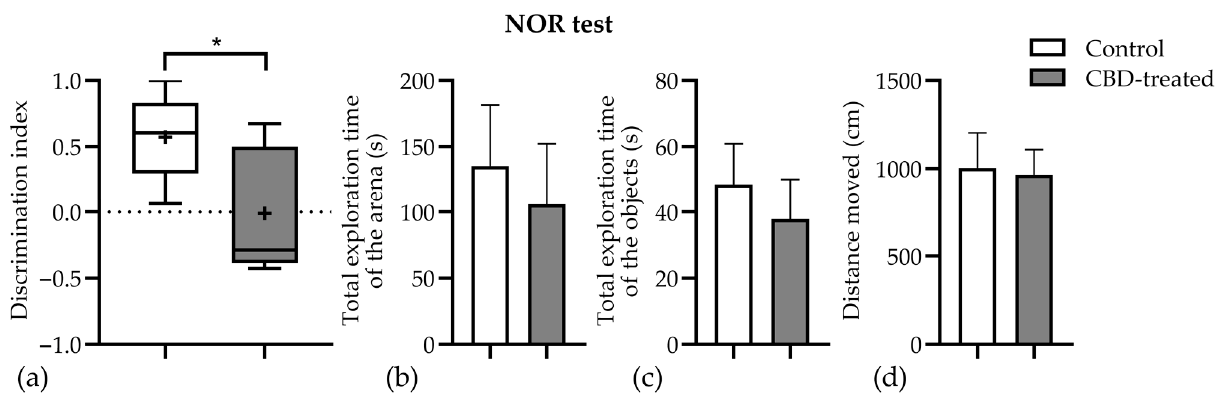
Figure 6. The effects of chronic CBD (60 mg/kg body weight) treatment on cognitive performance of rats subjected to a PTZ-kindling protocol. ( a ) Discrimination index (DI), which shows the discrimination between the novel and familiar objects, i.e., the difference in exploration time for a familiar object, but then dividing this value by the total amount of exploration of the novel and familiar objects [DI = (TN − TF)/(TN + TF)] showed a significant decrease in the CBD-treated group. + sign shows the arithmetic mean, whereas the line represents the median; ( b ) the total exploration time of the arena (mean ± SEM) did not show statistically significant difference between groups; ( c ) the total exploration time of the objects (mean ± SEM) was also similar for both groups; ( d ) the total distance moved by both groups (mean ± SEM) during the 5 min testing session was almost equal, and the results were similar to those found in the OF test. CBD, cannabidiol; * p < 0.05 vs. control. Data are expressed as mean ± SEM ( n = 7–11) for each